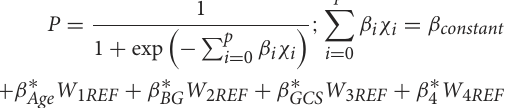
TABLE 4 Estimate of risk corresponding to total